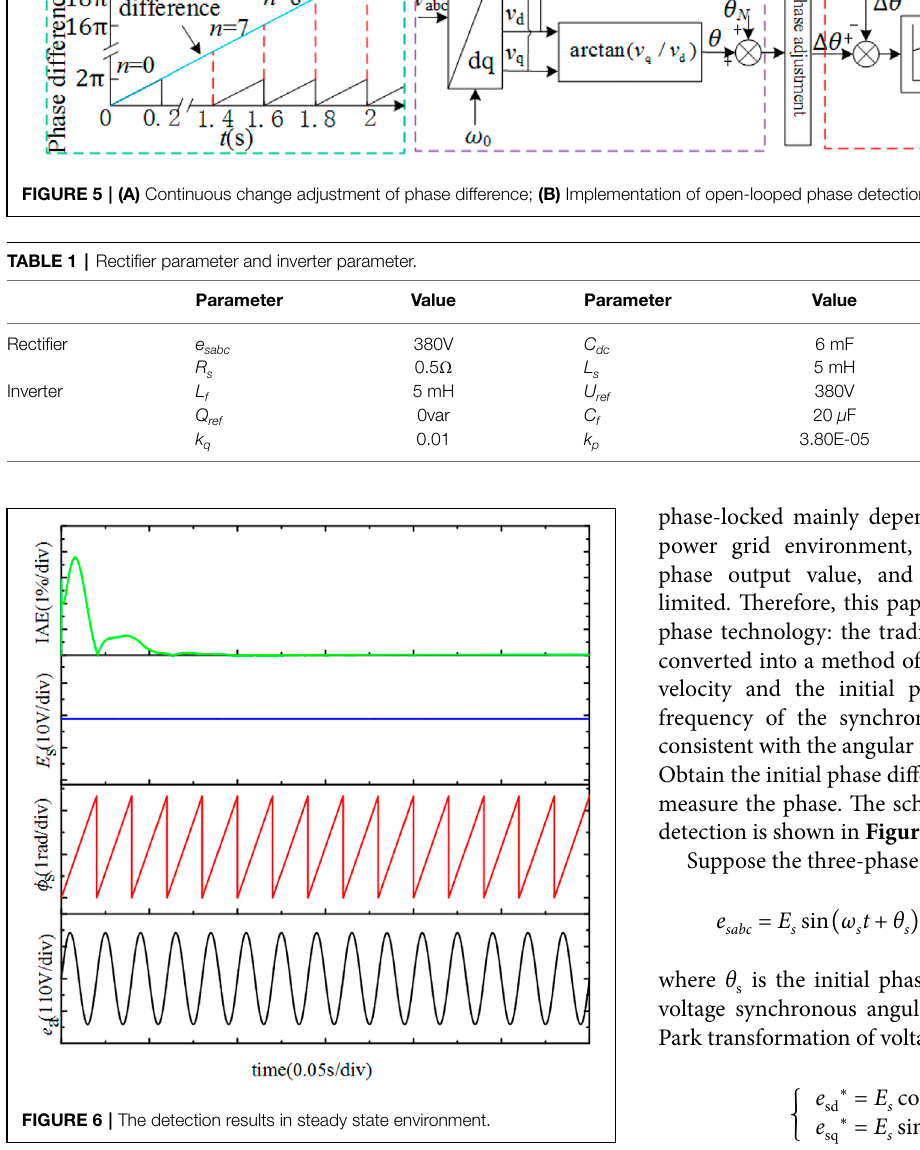
system and the voltage vector is continuously reduced until the quadrature axis component of the voltage vector is zero. Finally, the phase, voltage amplitude, and frequency are